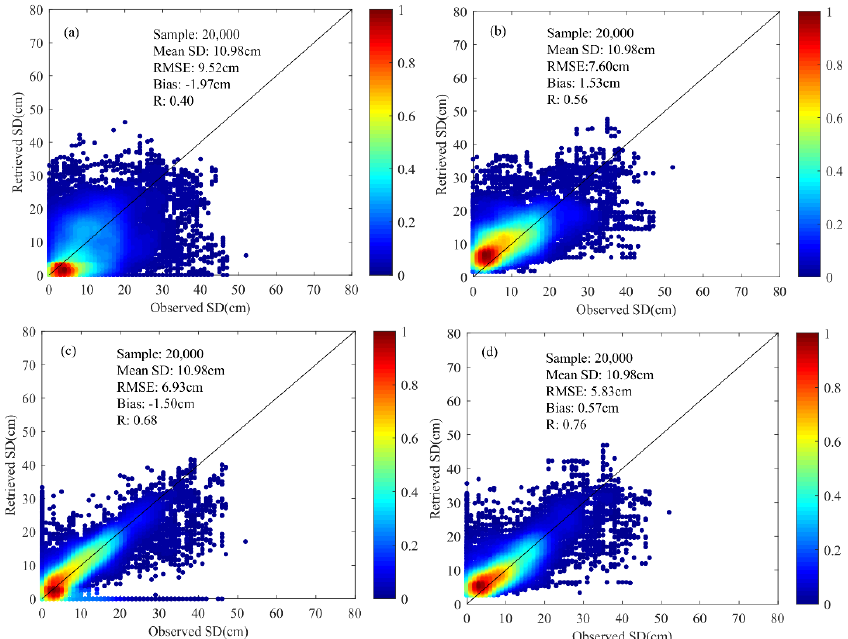
Figure 12. The color–density scatterplots of the retrieved SD and the observed SD at ground meteorological stations. ( a , c ) represent the raw WESTDC SD product and the FY SD product, respectively. ( b , d ) represent the corresponding downscaling results based on the multifactor SD downscaling model.